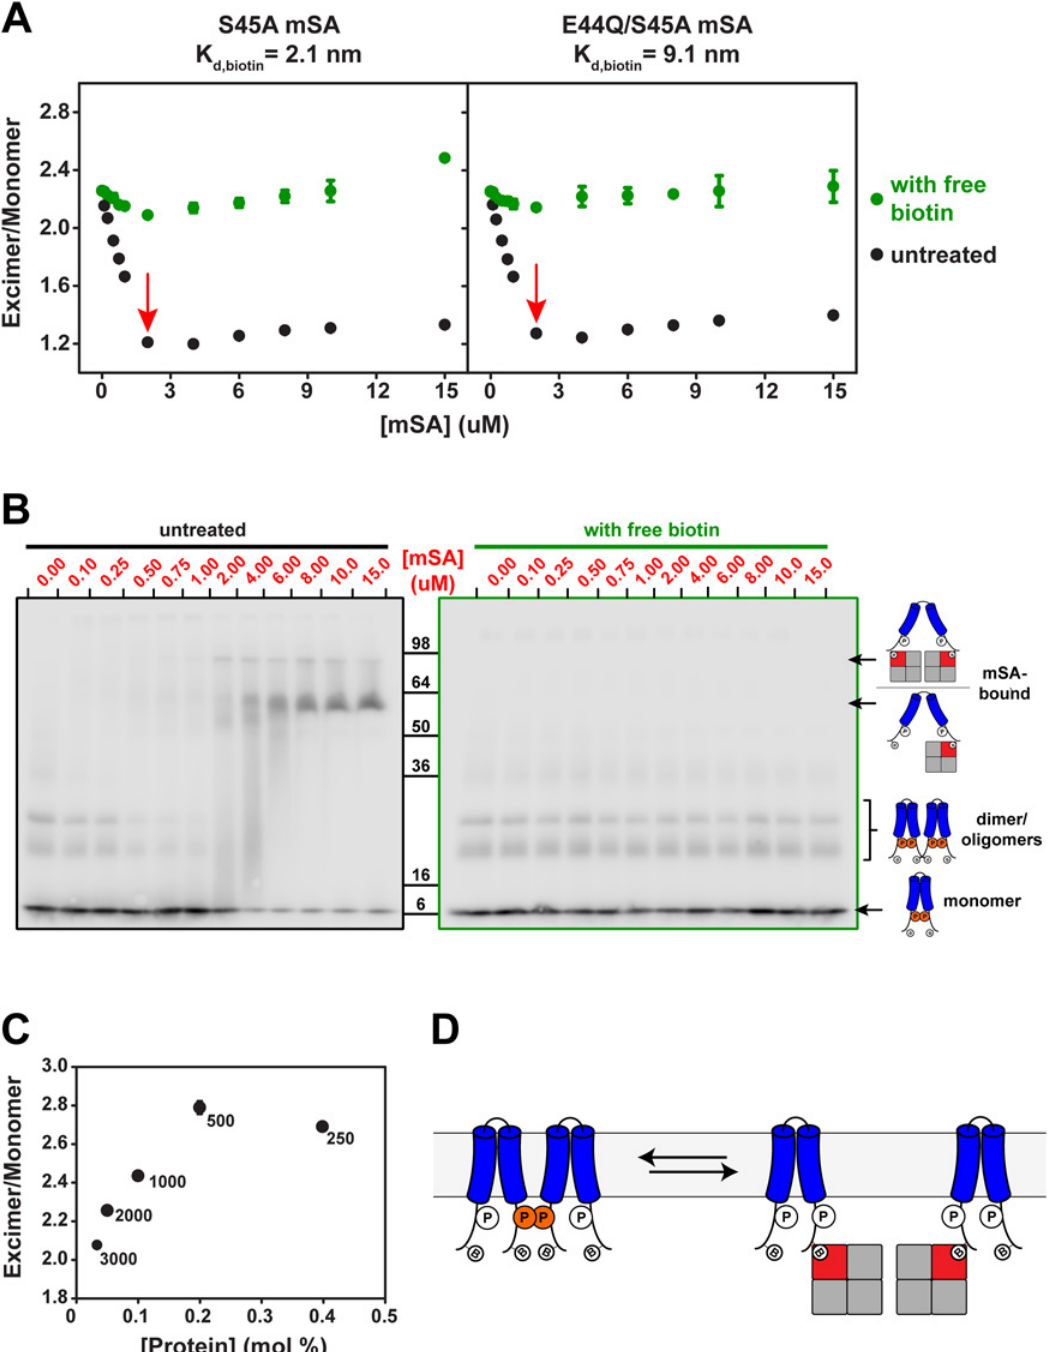
Fig 5. Unfolding and refolding TM3/4 Construct 2. ( A ) Monitoring the E/M ratio as a function of two mSA mutants with varying affinity towards biotin. Titrations are performed in 50 mM sodium phosphate pH 7.5, and 200 mM NaCl with a lipid/protein = 2000. With both mSA mutants, the E/M ratio drops by addition of mSA, indicating a loss in pyrene-pyrene contacts and therefore unfolding. The change in E/M ratio saturates upon reaching the total concentration of construct 2 ( i . e . 2 μ M, red arrows ). On the other hand, addition of excess 3.75 mM free biotin samples after measurement leads to an almost complete negation of mSA effects on the E/M ratio, highlighting the reversibility of the unfolding reaction. Points shown are the average of three independent experiments; error bars indicate +/- standard deviation. ( B ) Effect of E44Q/S45A mSA titration monitored by separation of TM3/4 populations on SDS-PAGE. Detection is specific towards TM3/4 constructs using Western blotting against an S-tag. The mSA-biotin interaction is SDS-resistant, since samples were not boiled and SDS-PAGE was run on ice. On the left panel, small oligomers and the monomeric form of TM3/4 are observed without mSA and disappear as it